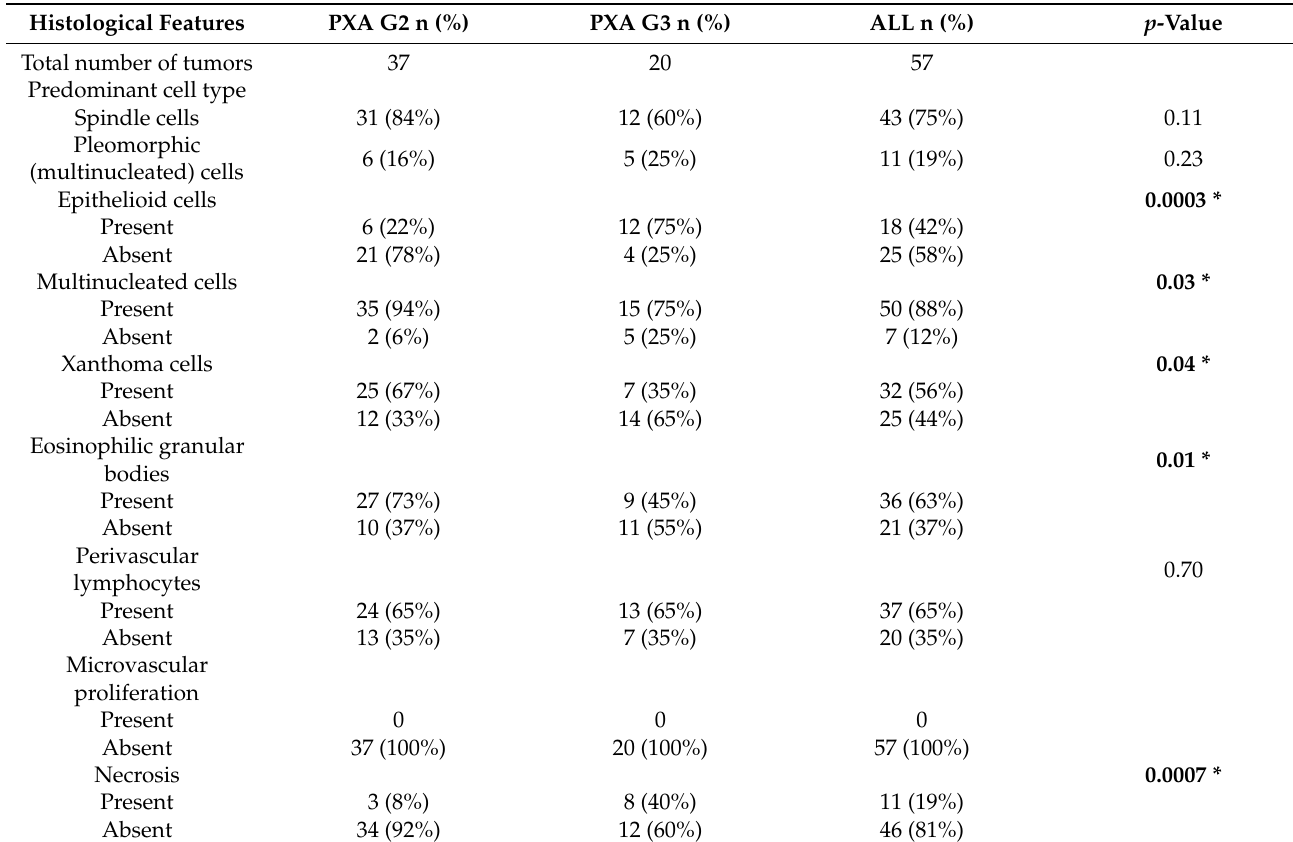
Table 2. Histological features of